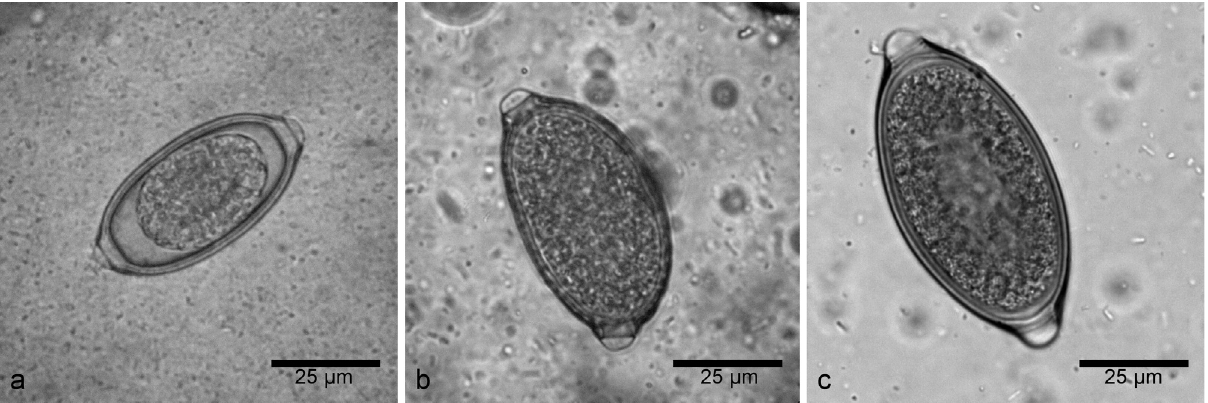
Fig. 2. – Light microscopy: a. Eucoleus aerophilus egg (bottom) and Trichuris vulpis egg (top); b. Euco- leus boehmi egg (right) and Trichuris vulpis egg